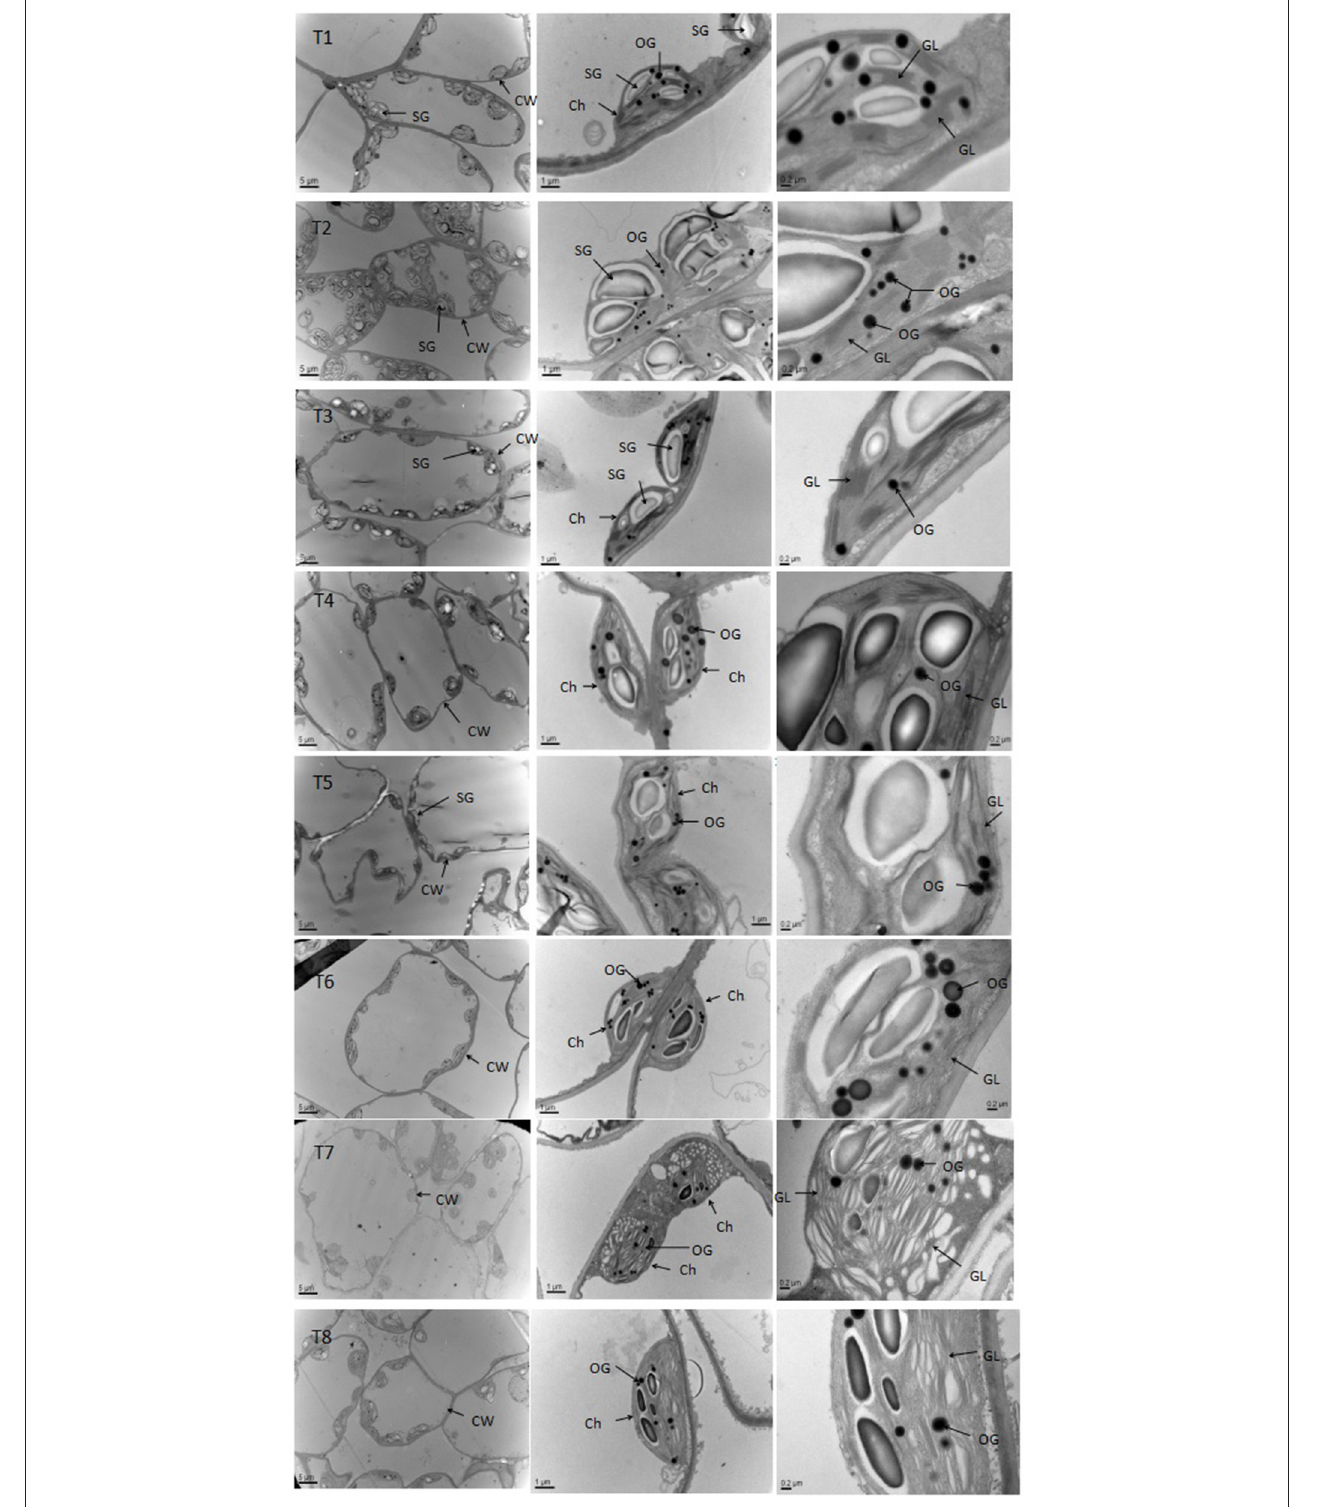
FIGURE 7 | Effects of SA on the chloroplast ultrastructure of D. superbus grown under salt stress (means ± SD ). Ch, chloroplast; CW, cell wall; SG, starch grains; OG, osmiophilic granule; GL, grana lamella.